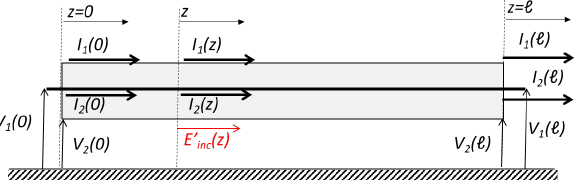
FIGURE 9. One-conductor shielded cable used for the derivation of the two-steps approach application domain The length of the cable is ℓ . [ I(z) ] and [ V(z) ] are respectively the current and voltage vectors at a position z along the